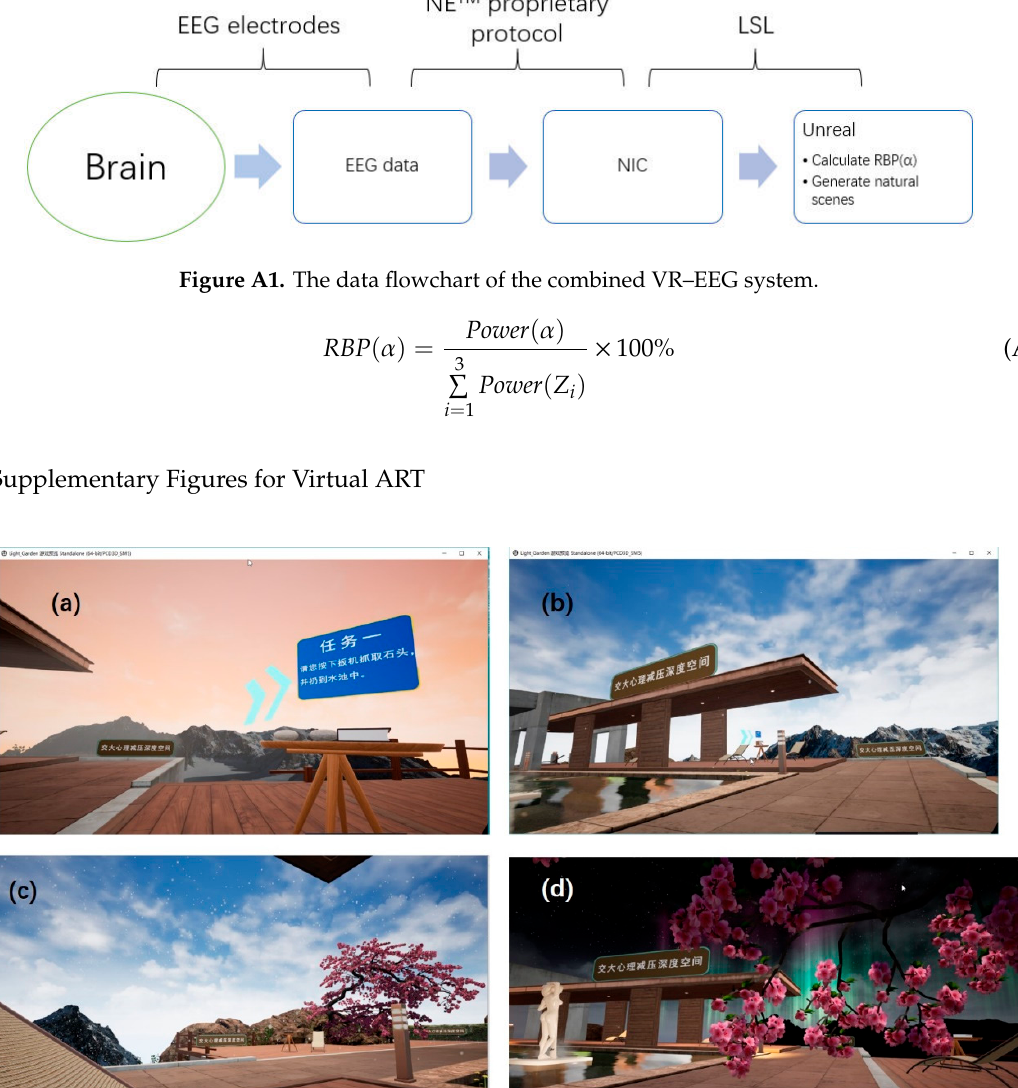
Figure A3. Visual oddball tasks.